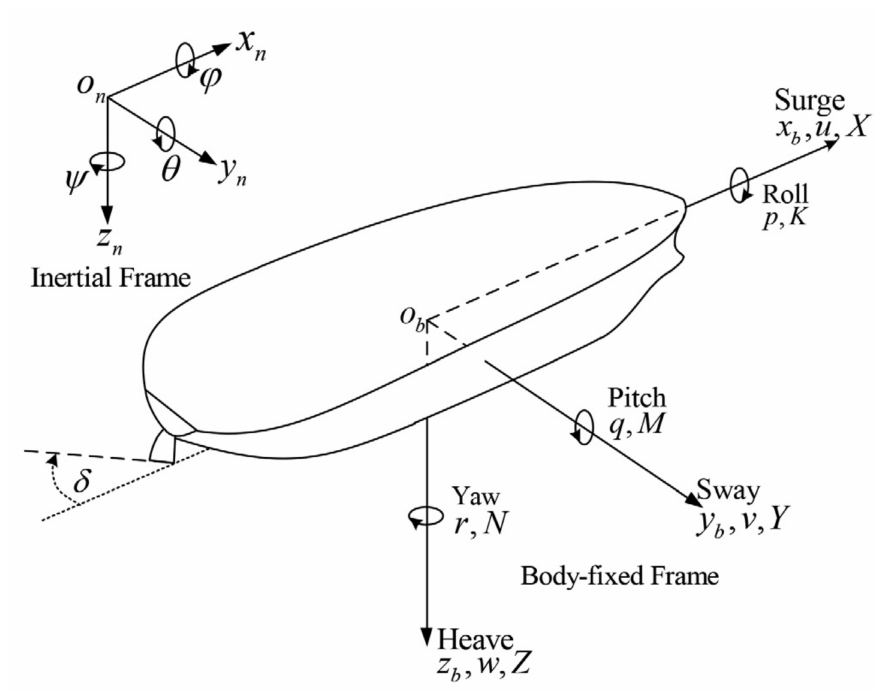
Figure 1. Coordinate system for ship